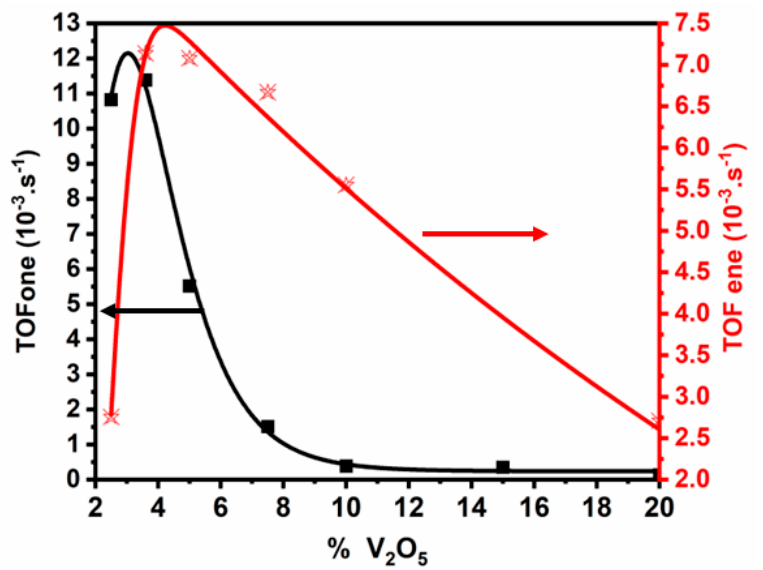
Figure 2. Turnover frequency (TOF) variation depending on the vanadium content (wt% = 2.5, 3.6, 7.5, 10, and 20) at 205 °C under reaction mixture air + 2-butanol.